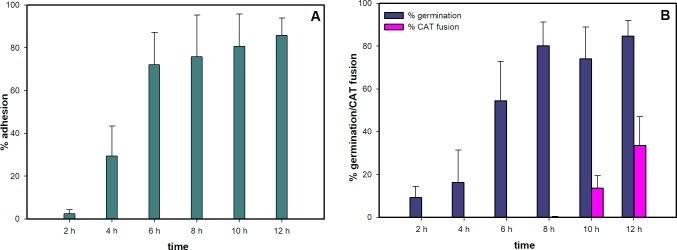
(A) Rate of adhesion of microconidia and microconidial germlings in 1% PDB + 25 mM NaNO3. (B) Rate of microconidial germination and CAT fusion in 1% PDB + 25 mM NaNO3. 1x106 spores/ml were used.